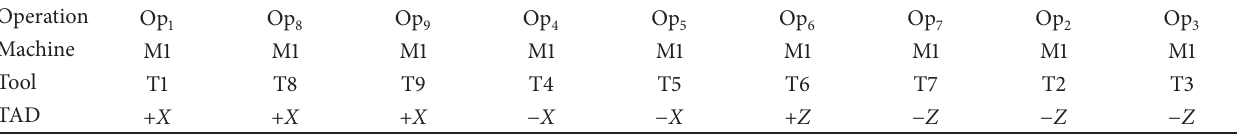
Table 6: An optimal process plan for the example part in Figure